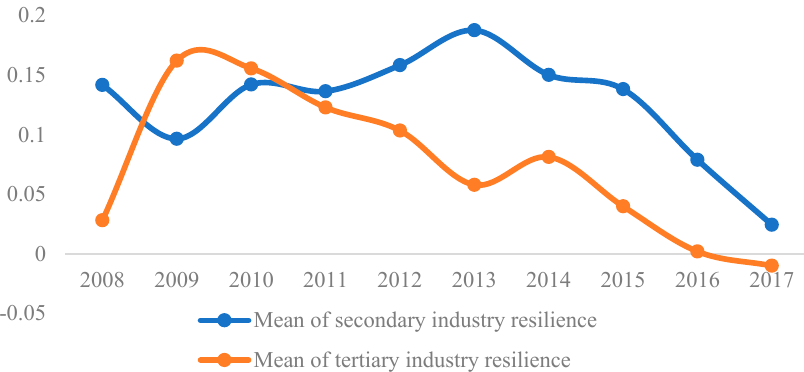
Figure 5. Mean of secondary and tertiary industries’ resilience of coastal areas in China.